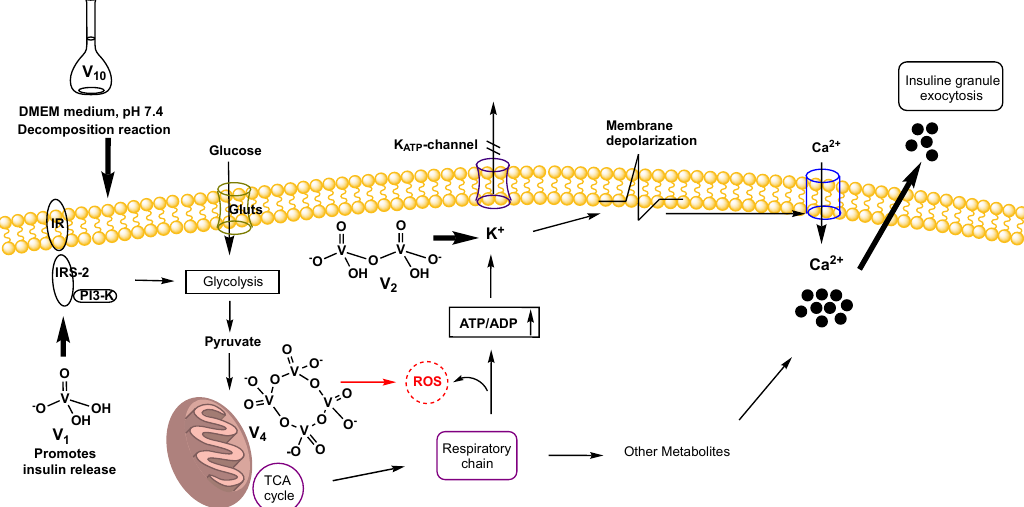
Figure 8. Illustration of the vanadium species mechanisms of action on the insulin release in βTC-6 cells. The total vanadium concentration is 300 μM, NaDeca decomposition reaction is moderately faster than MetfDeca reaction (Table 1), so NaDeca and MetfDeca majority decomposition products are V 1 and V 4 ; however, some V 2 is present, the putative mechanism of action for V 1 is that enhanced tyrosine phosphorylation, and on that way, V 1 species is able to further augment insulin secretion. A second putative mechanism involves inhibition of the K ATP channel by V 2 species.